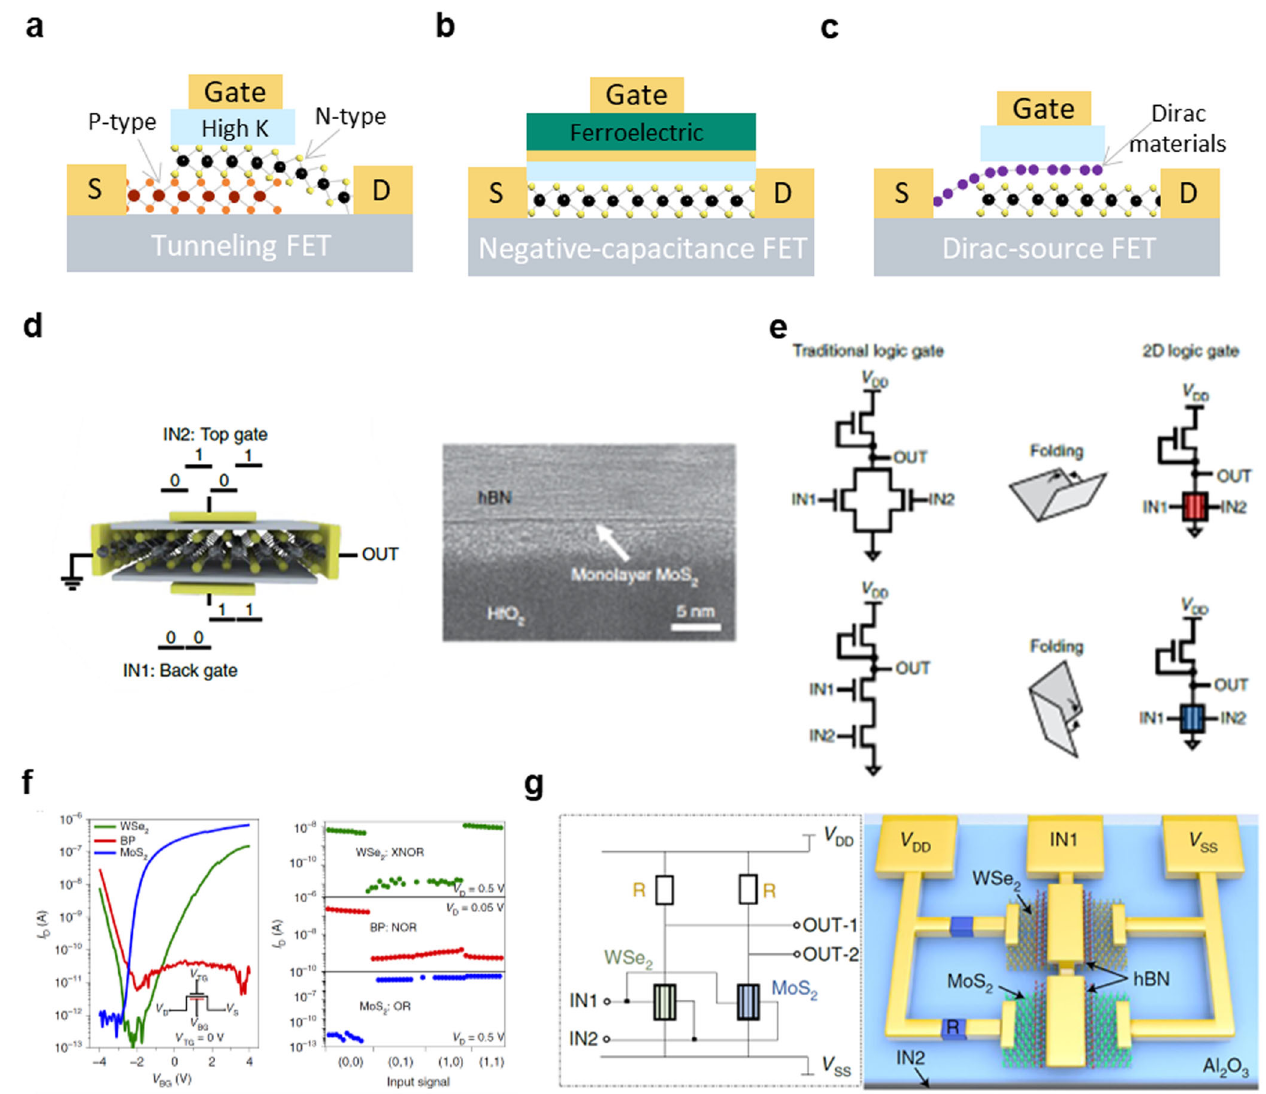
Fig. 6 2D semiconductors for computing. a Cross-sectional transistor schematic of a tunnelling FET. b Cross-sectional transistor schematic of a negative-capacitance FET. c Cross-sectional transistor schematic of a Dirac-source FET. d Illustration of logic gate based on the single MoS 2 transistor. The left penal shows the schematic structure and the right penal shows the cross-sectional TEM image. e Comparison of traditional logic gates and 2D logic gates. d , e are reproduced from ref. 84 . f Transfer curves and logic behaviour of the logic gates based on WSe 2 (ambipolar-type), BP (p-type), and MoS 2 (n-type). g Schematic of a 2T2R circuit composed of a WSe 2 logic transistor, a MoS 2 logic transistor, and two resistors. f , g are reproduced from ref. 85